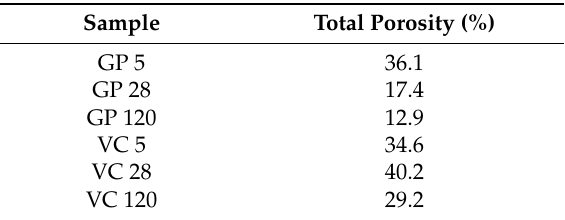
Table 5. Total porosity of GP and VC aggregates.